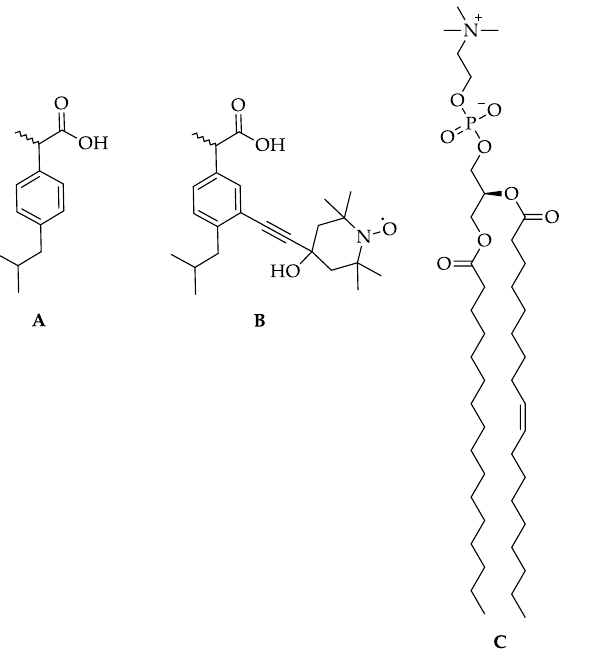
Figure 1. Chemical structures: (A) ibuprofen, (B) spin-labeled ibuprofen (ibuprofen-SL), and (C) zwitterionic lipid POPC.